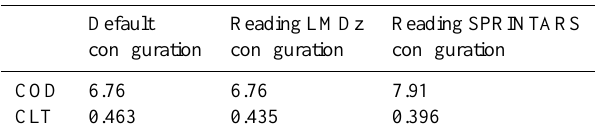
Table 5. Clouds characteristics for the default, reading LMDz and reading SPRINTARS configurations: cloud optical depth (COD) and 2-D cloud fraction